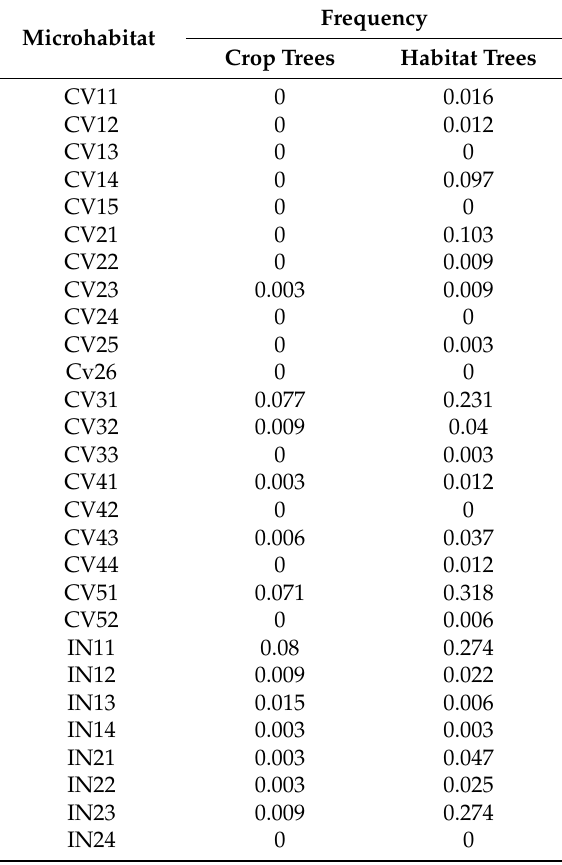
Table A2. Microhabitat frequency on crop trees and habitat trees. For microhabitat codes, see Table